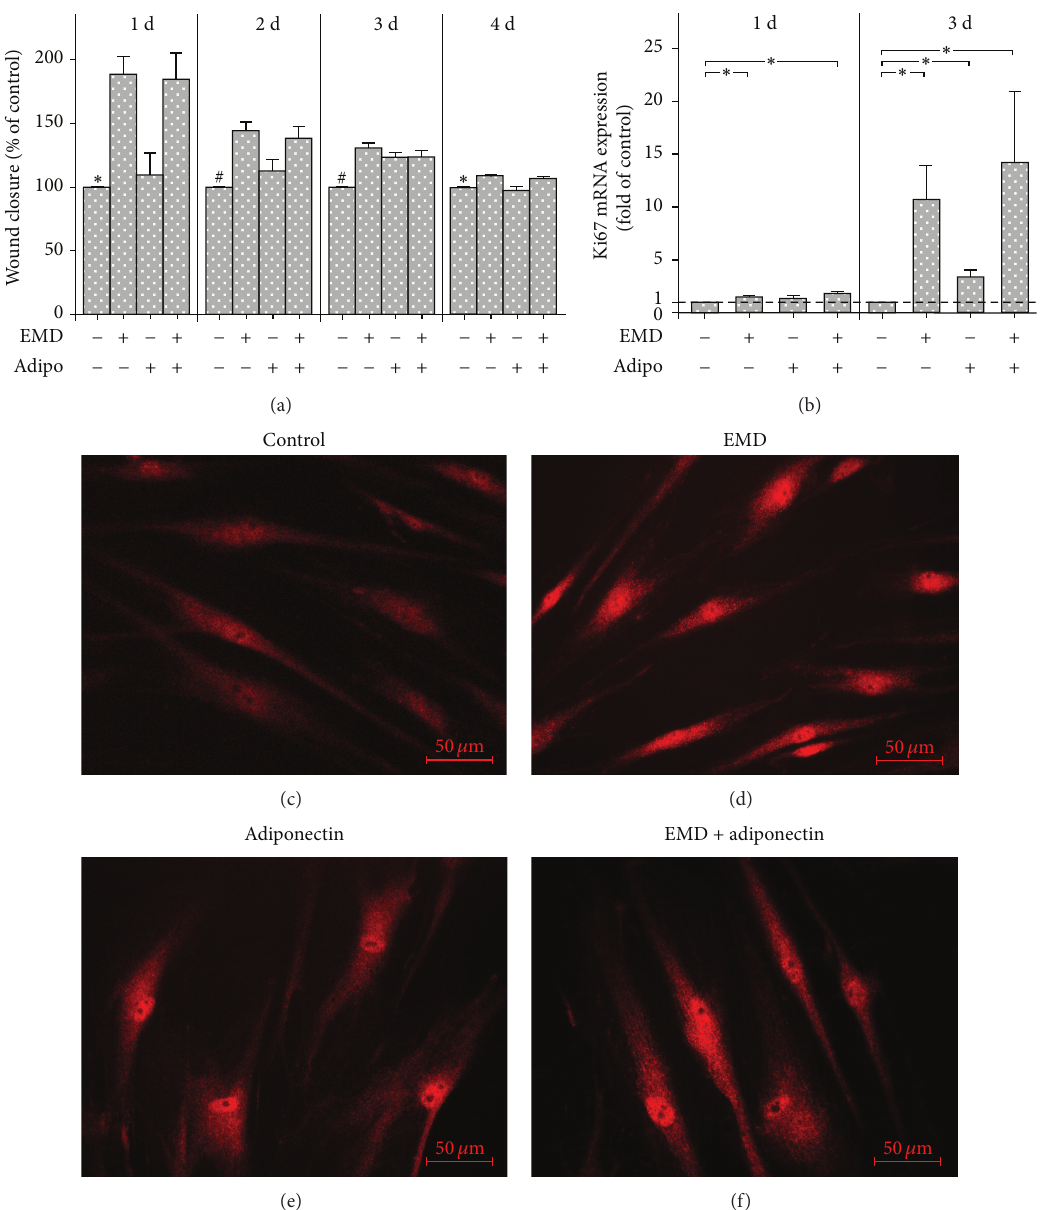
Figure 2: Effects of EMD and/or adiponectin (3 𝜇 g/mL) on wound closure over 4 d (a). Untreated cells were used as control. Mean ± SEM ( 𝑛 = 12 ); ∗ significantly ( 𝑃 < 0.05 ) different from cells treated with EMD, either alone or with adiponectin; # significantly ( 𝑃 < 0.05 ) different from all other groups. Effects of EMD and/or adiponectin (1 𝜇 g/mL) on the mRNA expression of Ki67 at 1d and 3 d (b). Untreated cells were usedascontrol.Mean ± SEM( 𝑛 = 18 ); ∗ significant( 𝑃 < 0.05 )differencebetweengroups.EffectsofEMDonSMAD1/5/8nucleartranslocation in the presence and absence of adiponectin (1 𝜇 g/mL) at 60 min, as analyzed by immunofluorescence (c–f). Untreated cells served as control. Experiments were performed in triplicate and repeated twice. Images from one representative donor are